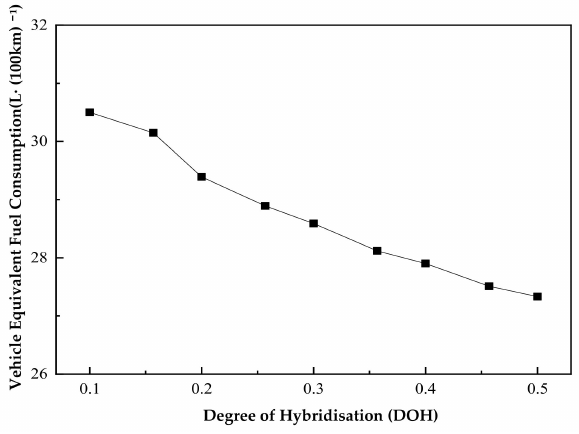
Figure 17. Curves of the equivalent fuel consumption with